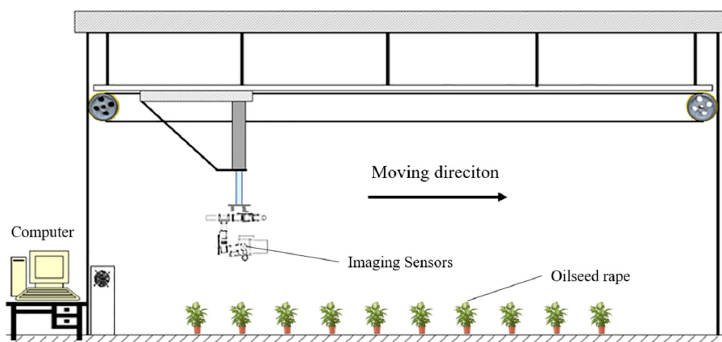
Figure 1. Schematic diagram of data acquisition system for disease detection.